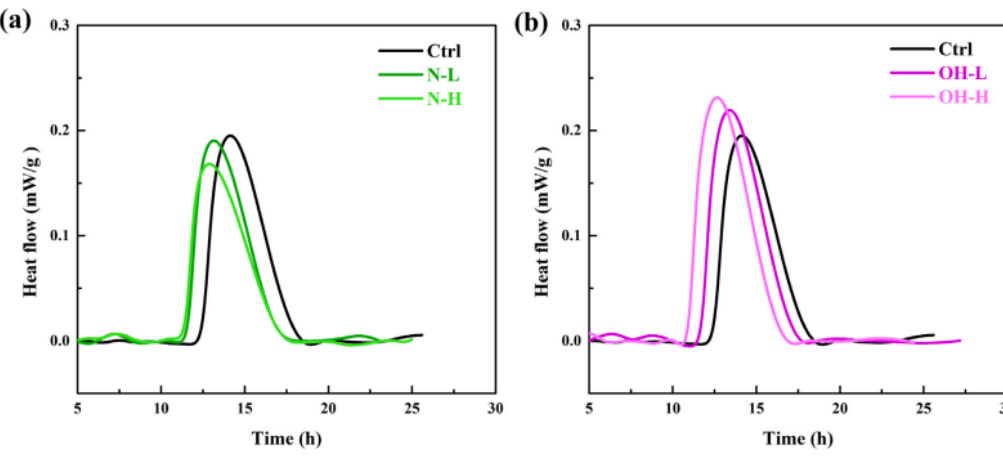
Figure 6: The determined heat flow curves of sulfate depletion peak in (a) N and (b) OH group (Chen et al.,